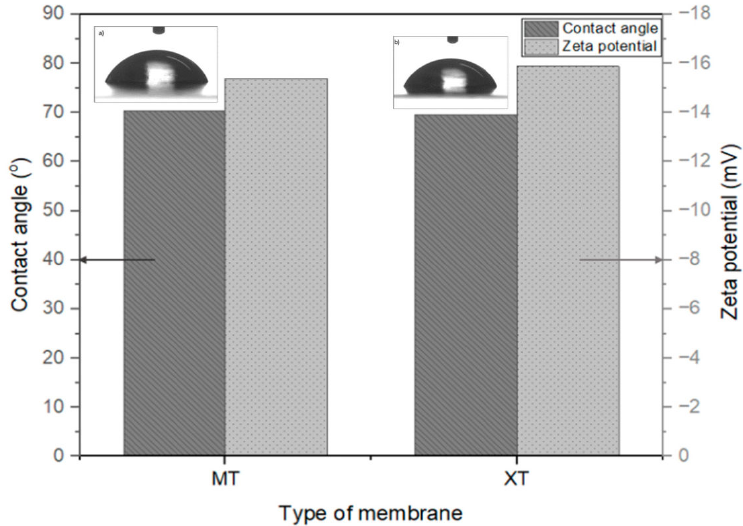
Figure 4. Comparison of the contact angle (inset shows the photographs of water droplet on the membranes) and the zeta potential measured for the commercial MT and XT